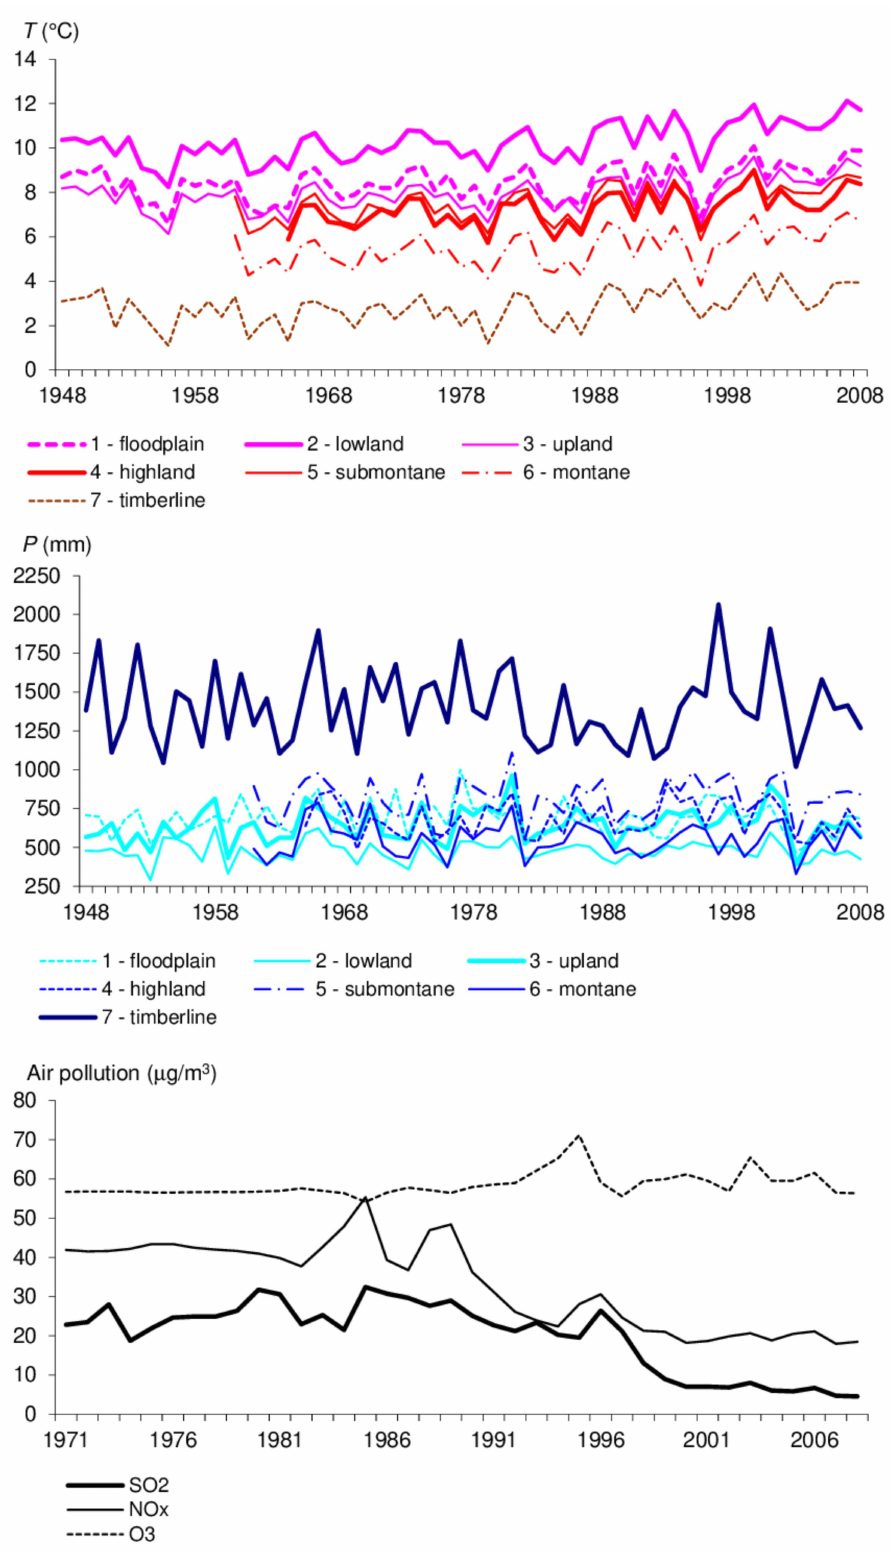
Figure 2. Development of year average temperatures ( T ), annual precipitation ( P ) and total atmo- spheric pollution concentrations at altitudinal zones covering sampled forest stand